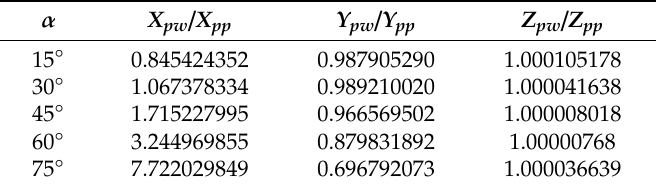
Table 3. Comparison of the locations of Van der Waals forces based on plate-plate and plate-wall model.